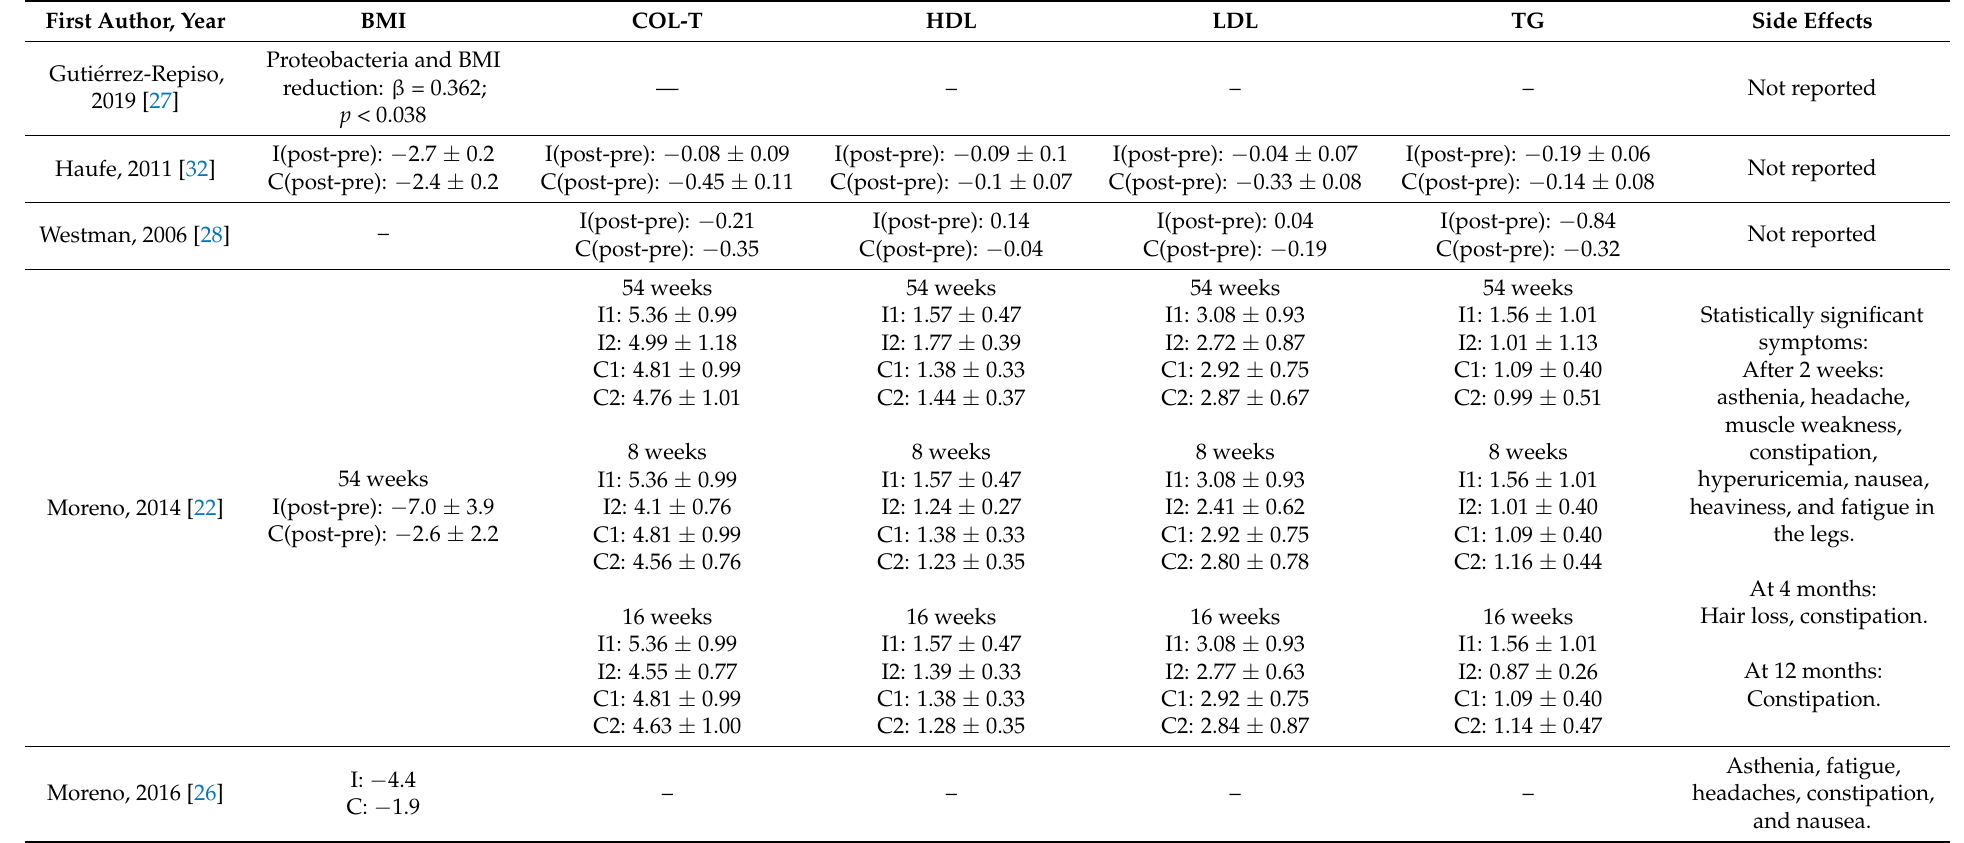
Table 2. Results of the studies